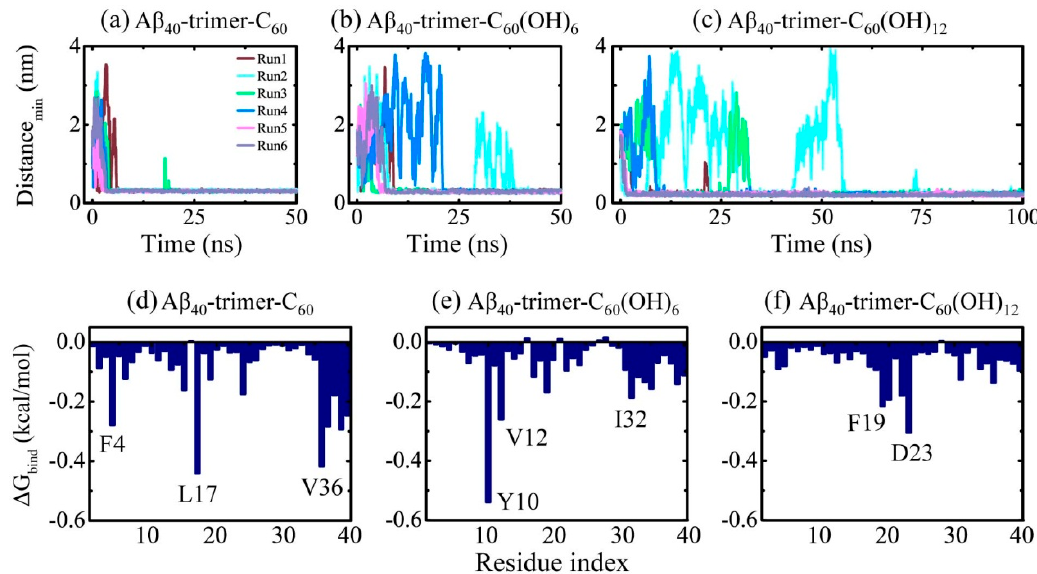
Figure 6. ( a – c ) Time evolution of the minimum distance between A β 40 -trimer and fullerene / fullerenol. Six independent MD runs are denoted in different colors. ( d – f ) Residue-based binding free energy. The binding energy was calculated over all six MD runs for each simulated system using the last 20 ns data of each MD trajectory.